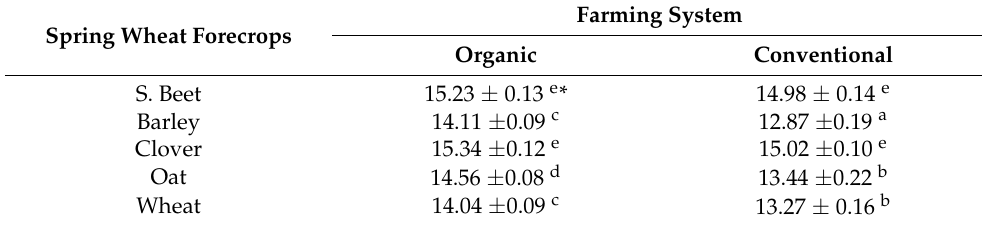
Table 6. Wheat grain protein content (%). Farming System Spring Wheat Forecrops Organic Conventional S. Beet 15.23 ± 0.13 e * Barley Clover 15.34 ± 0.12 e Oat Wheat 14.04 ± 0.09 c 13.27 ± 0.16